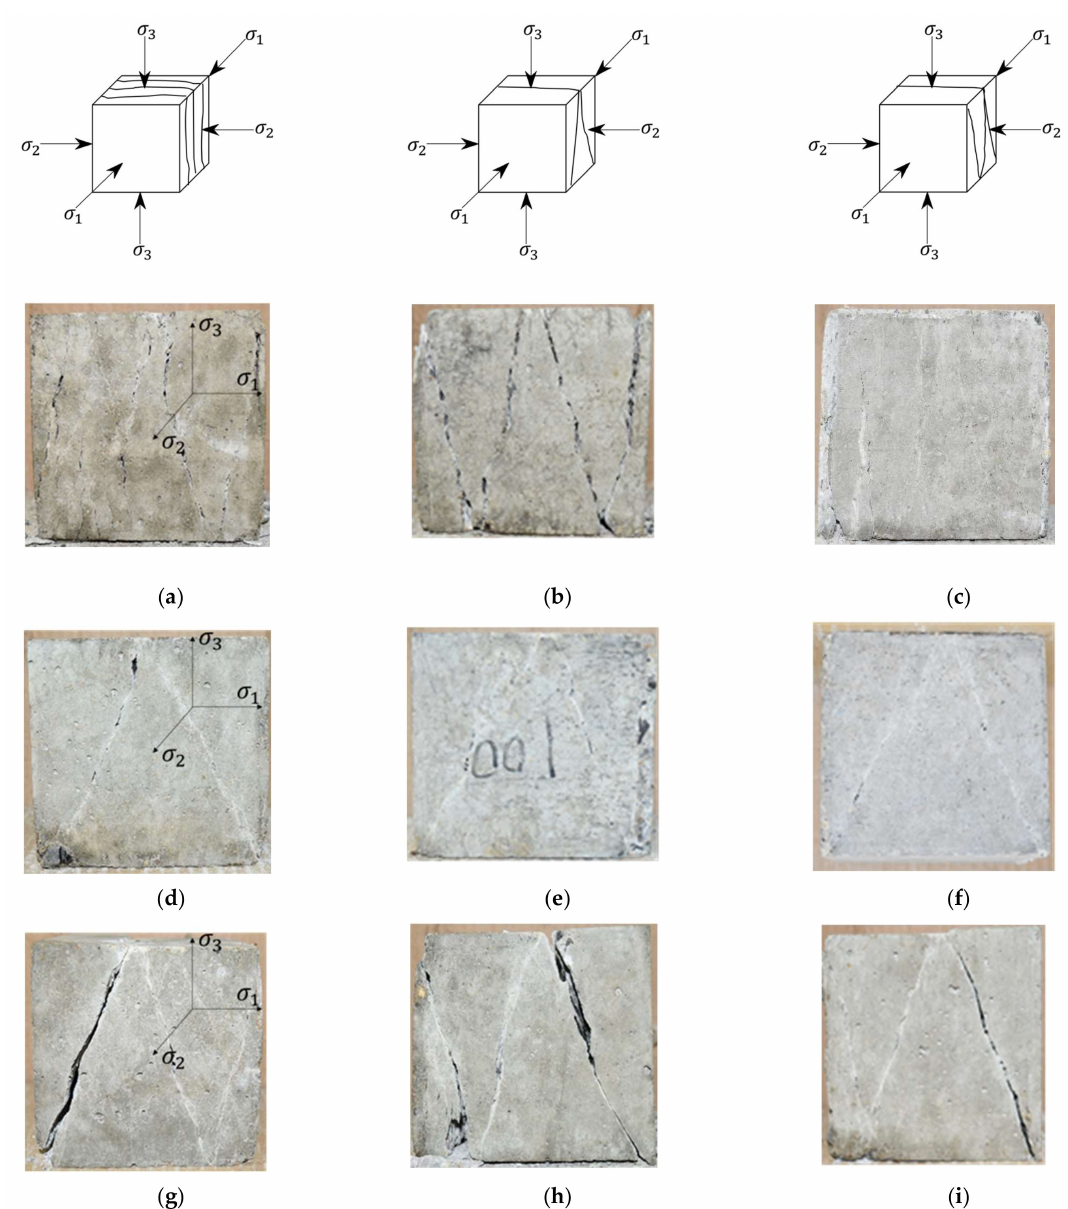
Figure 4. Schematic diagram of failure form under triaxial compression: ( a ) Plate-splitting cracks, σ 1 : σ 2 : σ 3 = 0.05:0.25:1, SSC-70; ( b ) 0.05:0.25:1, SSC-100; ( c ) 0.1:0.25:1, SSC-70; ( d ) Single-shear cracks, 0.05:0.5:1, SSC-70; ( e ) 0.05:0.75:1, SSC-100; ( f ) 0.1:0.75:1, SSC-100; ( g ) Double-shear cracks, 0.05: 0.75:1, SSC-70; ( h ) 0.05:0.5:1, SSC-100; ( i ) 0.1:1:1,